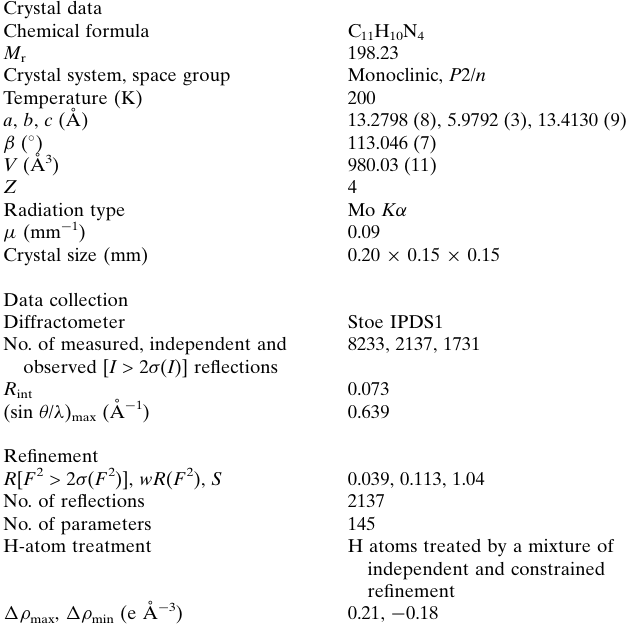
Crystal data Chemical